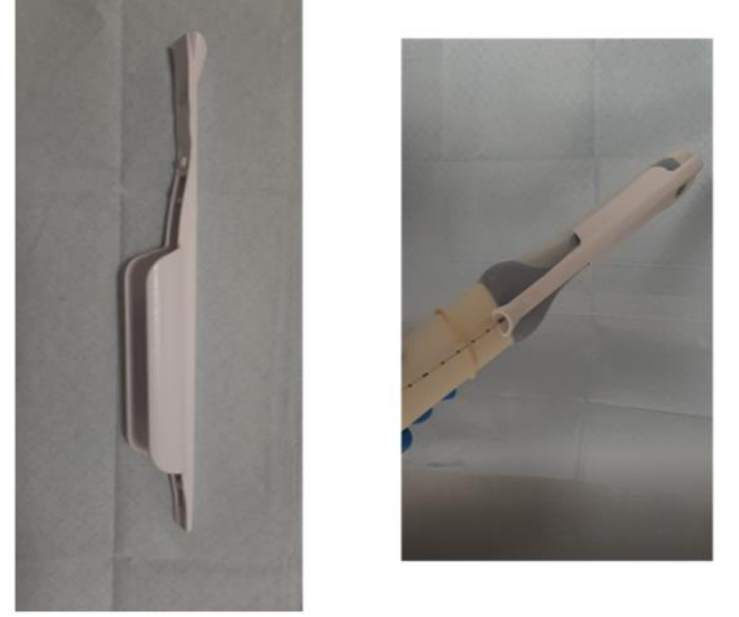
Figure 1. Biopsy guide attached to the transvaginal probe through which a needle or puncture device is inserted.